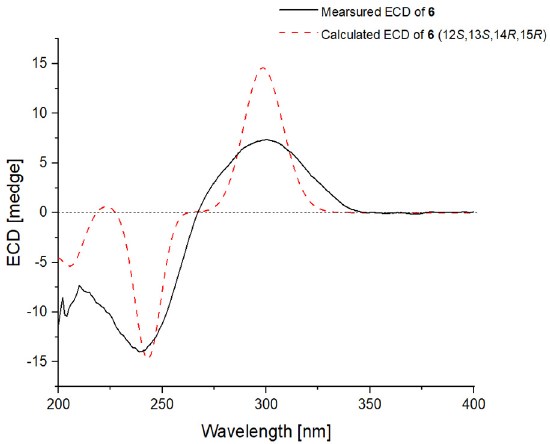
15 Figure 9. Two possible isomers of compound 5 for DP4+ probability analysis. Poloncosidin F ( 6 ) was obtained as a colorless oil with a molecular formula of C 23 H 32 O 6 as determined by the HRESIMS data. Its 1 H- and 13 C-NMR data (Tables 1 and 2) revealed a close structural relationship with deoxyverrucosidin ( 7 ) [3]. One of the visible differences were that the signals for a methoxy group 3-OCH 3 ( δ H 3.83; δ C 60.2) in the NMR spectra of deoxyverrucosidin ( 7 ) were absent in those of 6. Moreover, a de-shielded resonance for C-3 ( δ C 177.0) and a shielded field shift for C-2 ( δ C 89.9) were clearly observed in the 13 C-NMR spectrum of 6 (Table 2), compared to those of 7 [3]. These spectroscopic features as well as in considering the molecular formula revealed that the